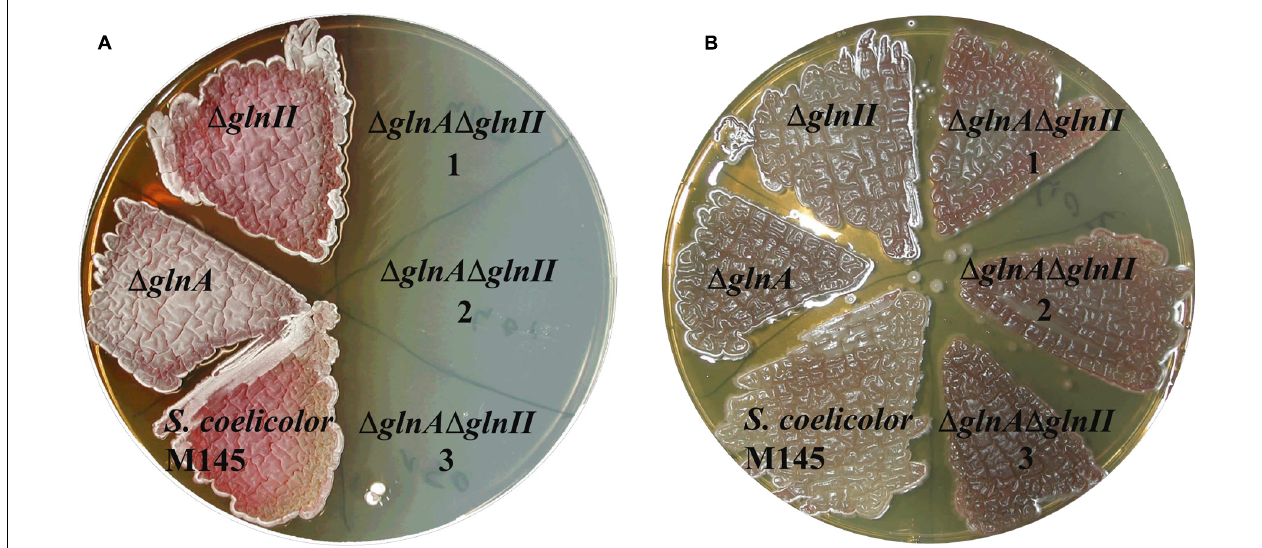
FIGURE 2 | Phenotypic analysis of parental strain S. coelicolor M145 and mutants: (cid:49) glnA, (cid:49) glnII and (cid:49) glnA (cid:49) glnII (1, 2, 3 – independent clones) on defined Evans medium supplemented with 50 mM ammonium chloride (A) or with 50 mM ammonium chloride and 50 mM L -glutamine (B) . Deletion of both genes, glnA and glnII, for GSs, resulted in a glutamine auxotrophic phenotype indicating that GlnA2, GlnA3, and GlnA4 were incapable to substitute GSI and GSII metabolic function in the